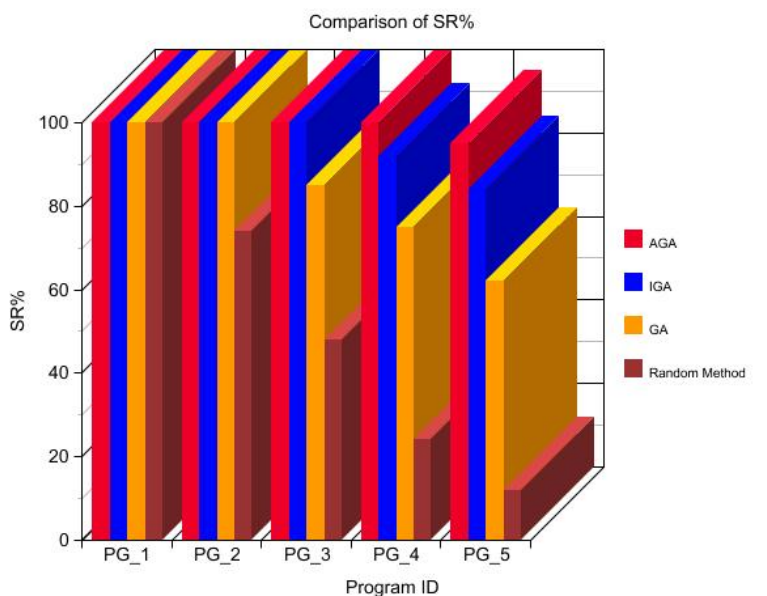
Figure 10. Comparison of success rate in industrial program data.